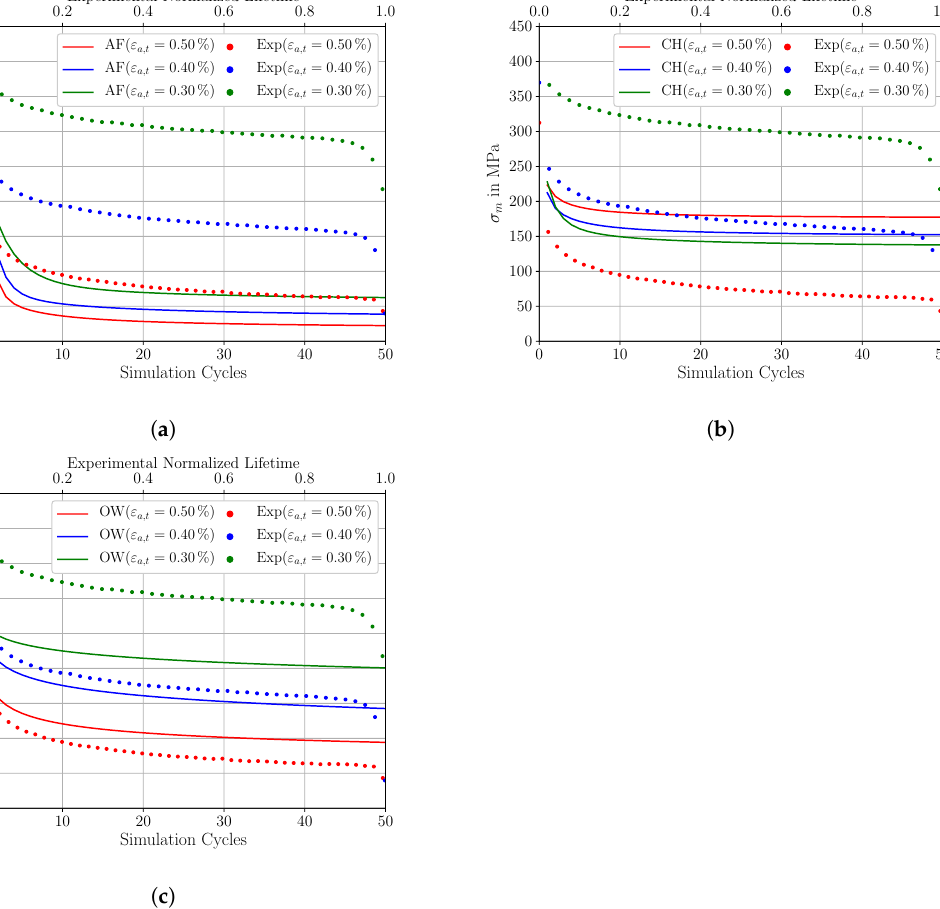
Figure 14. Comparison of the mean stress relaxation behavior at R ε = 0 for three different total strain amplitudes ε a , t = 0.30%, ε a , t = 0.40% and ε a , t = 0.50% between the micromechanical model prediction and the experimental results; ( a ) for the AF KH model ( b ) for the CH KH model and ( c ) for the OW KH